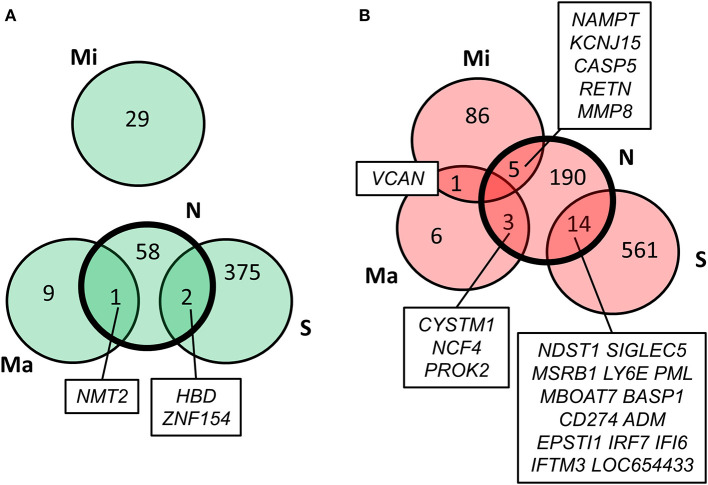
Comparison of our results with previous HD transcriptome analyses. Overlap of our set of dysregulated genes (N) with genes reported by Stopa et al. (22) (S), Mastrokolias et al. (19) (Ma), and Miller et al. (20) (Mi). (A) downregulated genes; (B) upregulated genes. Our set overlaps with the previous three datasets while the only overlap between the three previous datasets is the upregulation of VCAN in (19) and (20).